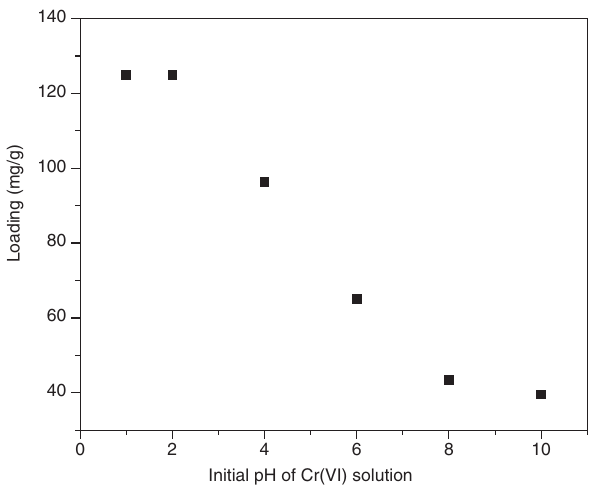
Figure 8 Effect of pH on the adsorption of Cr(VI) (initial concentra- tion = 500 mg/l, weight = 0.2 g, temperature = 30 ° C, time = 24 h).